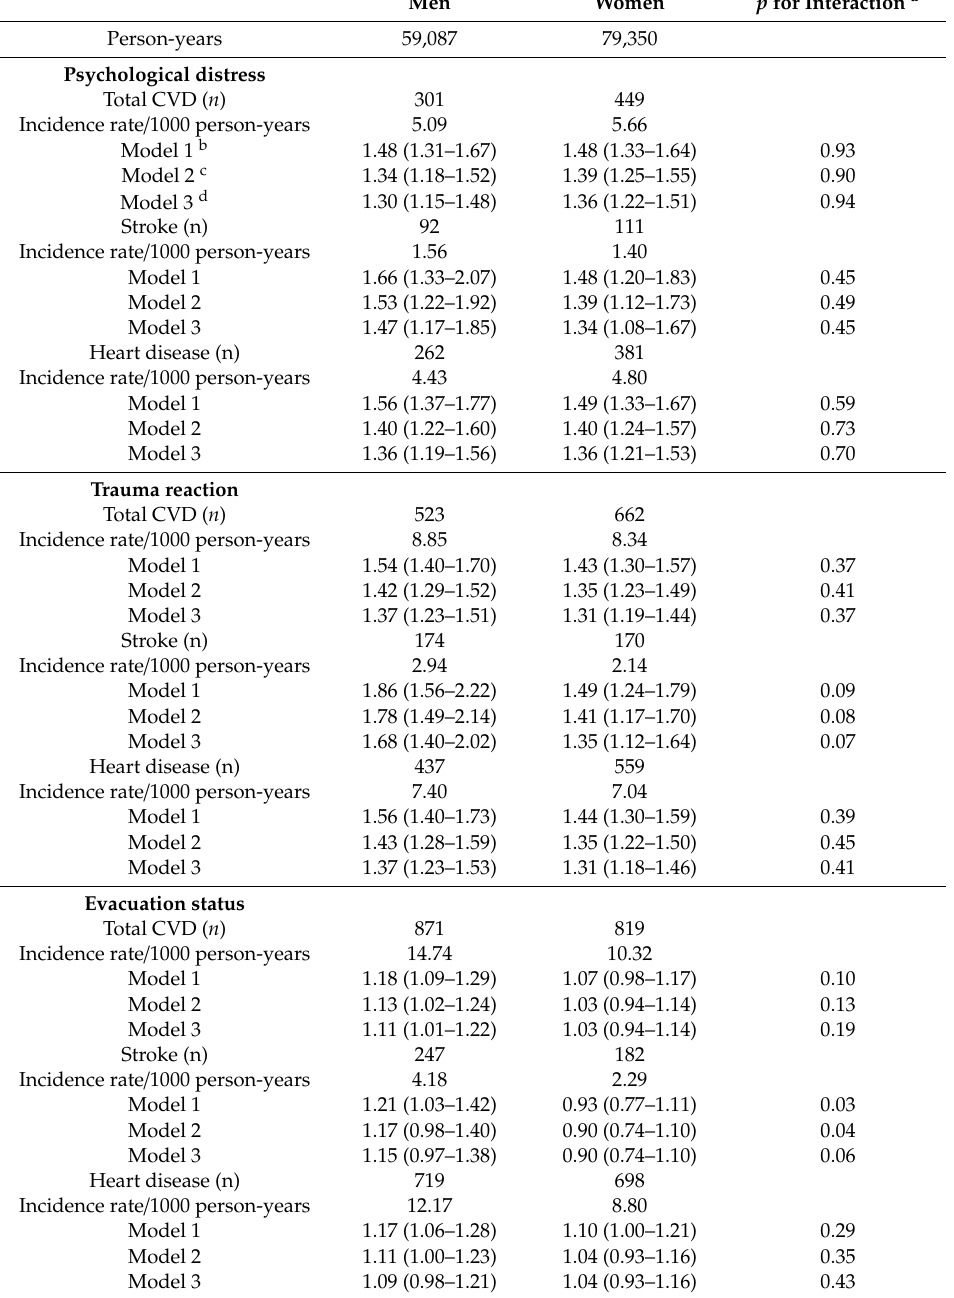
Table 2. Psychological factors or evacuation status-specific age-adjusted and multivariable HRs (95% CIs) of CVDs according to